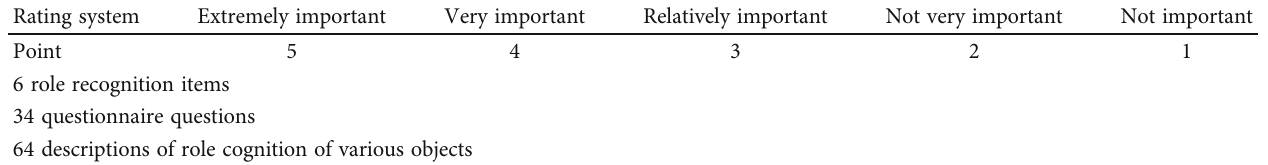
Table 1: Rating system of questionnaire design in the education system of Taiyuan City.